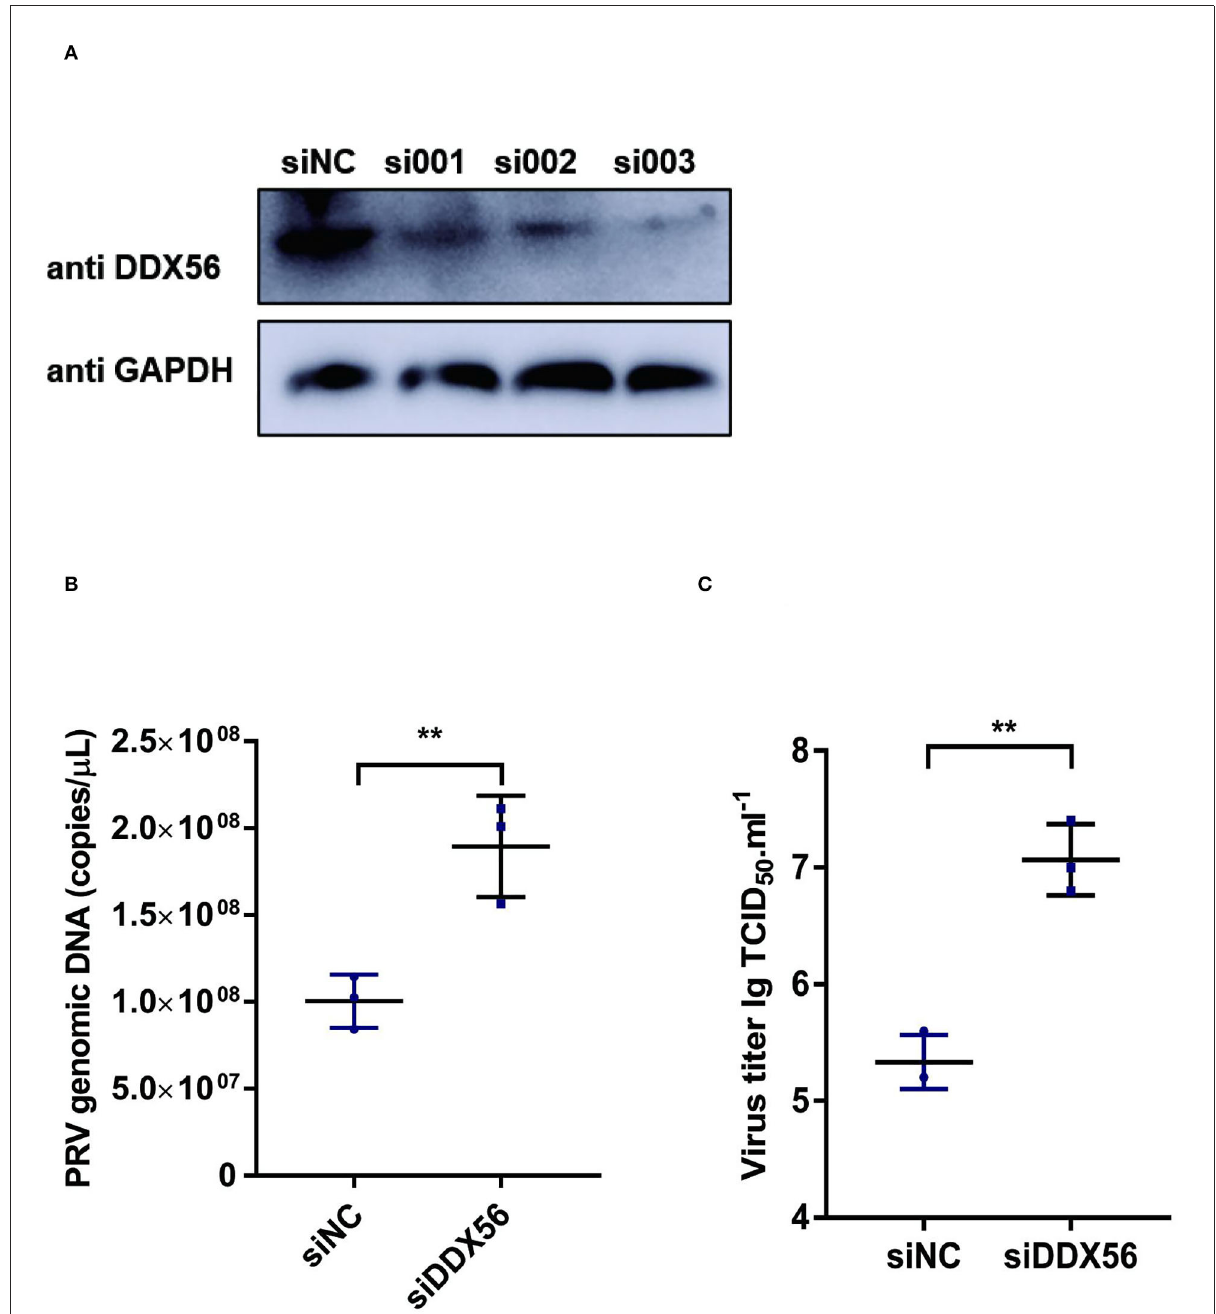
FIGURE2 Knockdown of DDX56 promotes PRV proliferation in PK15 cells. (A) siRNA targeting DDX56 was transfected into PK15 cells for 24h. Cells were lysed with RIPA and DDX56 (65 kDa) expression was determined by western blotting using an antibody specific for DDX56. GAPDH (37 kDa) served as loading control. (B,C) PK15 cells were transfected with siRNA targeting DDX56 (siRNA Mixture, siDDX56) for 24h then 100 TCID 50 PRV was inoculated into these cells for another 24h before measuring viral copy numbers and titers. Viral copy number was determined